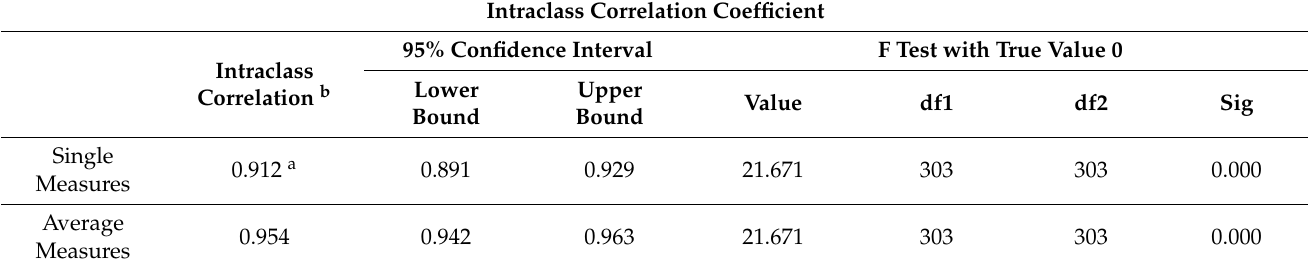
Table 5. Results of the ICC calculations using a mean of two raters, an absolute agreement, and a two-way random-effects model